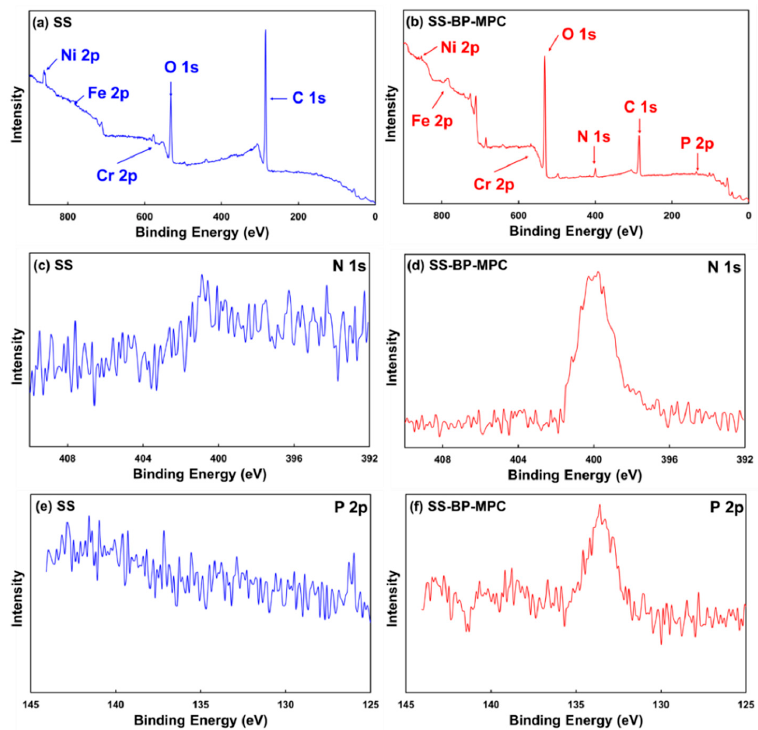
Figure 4. X-ray photoelectron spectroscopic (XPS) analysis for ( a , b ) full scan of pristine SS substrate and SS-BP-MPC composite, ( c , d ) N 1s spectra of pristine SS substrate and SS-BP-MPC composite, and ( e , f ) P 2p spectra of pristine SS substrate and SS-BP-MPC composite, respectively.